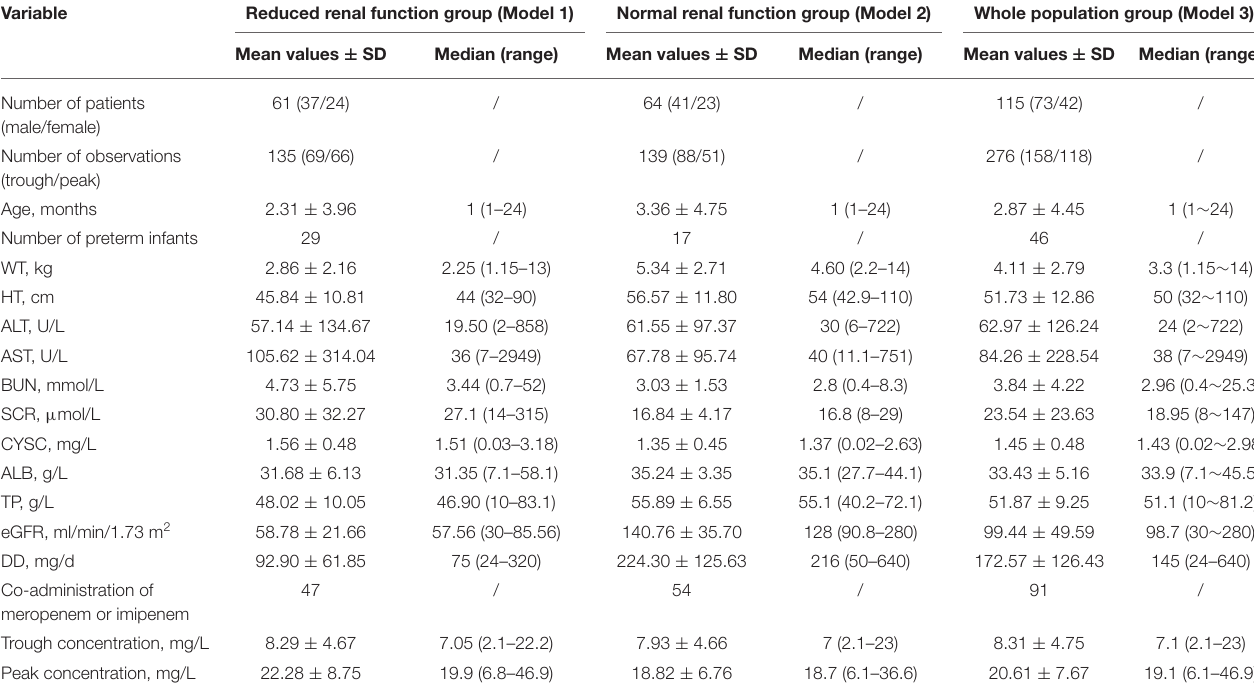
TABLE 2 | Demographic, laboratory and clinical data of the modeling groups.